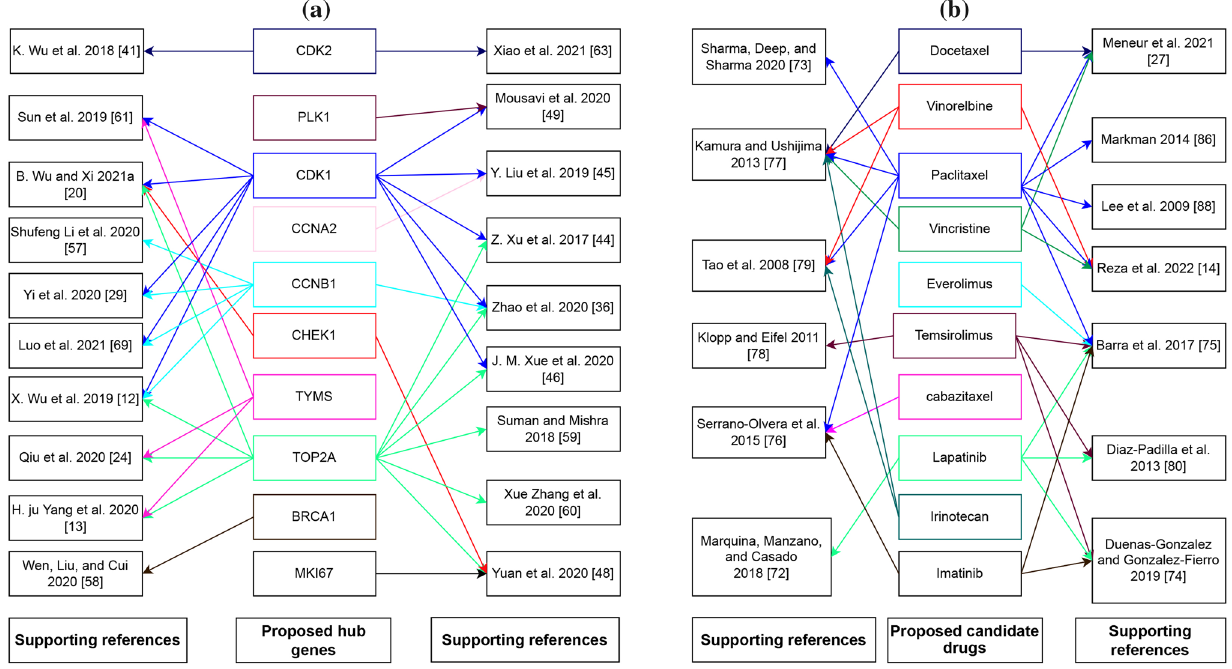
Fig. 9 a Proposed CC-causing hub genes (hHubGs) with supporting references, where a specific color indicates the references for a specific hub-gene. b Proposed candidate drugs (FDA approaved) with supporting references, where a specific color indicates the references for a specific candidate